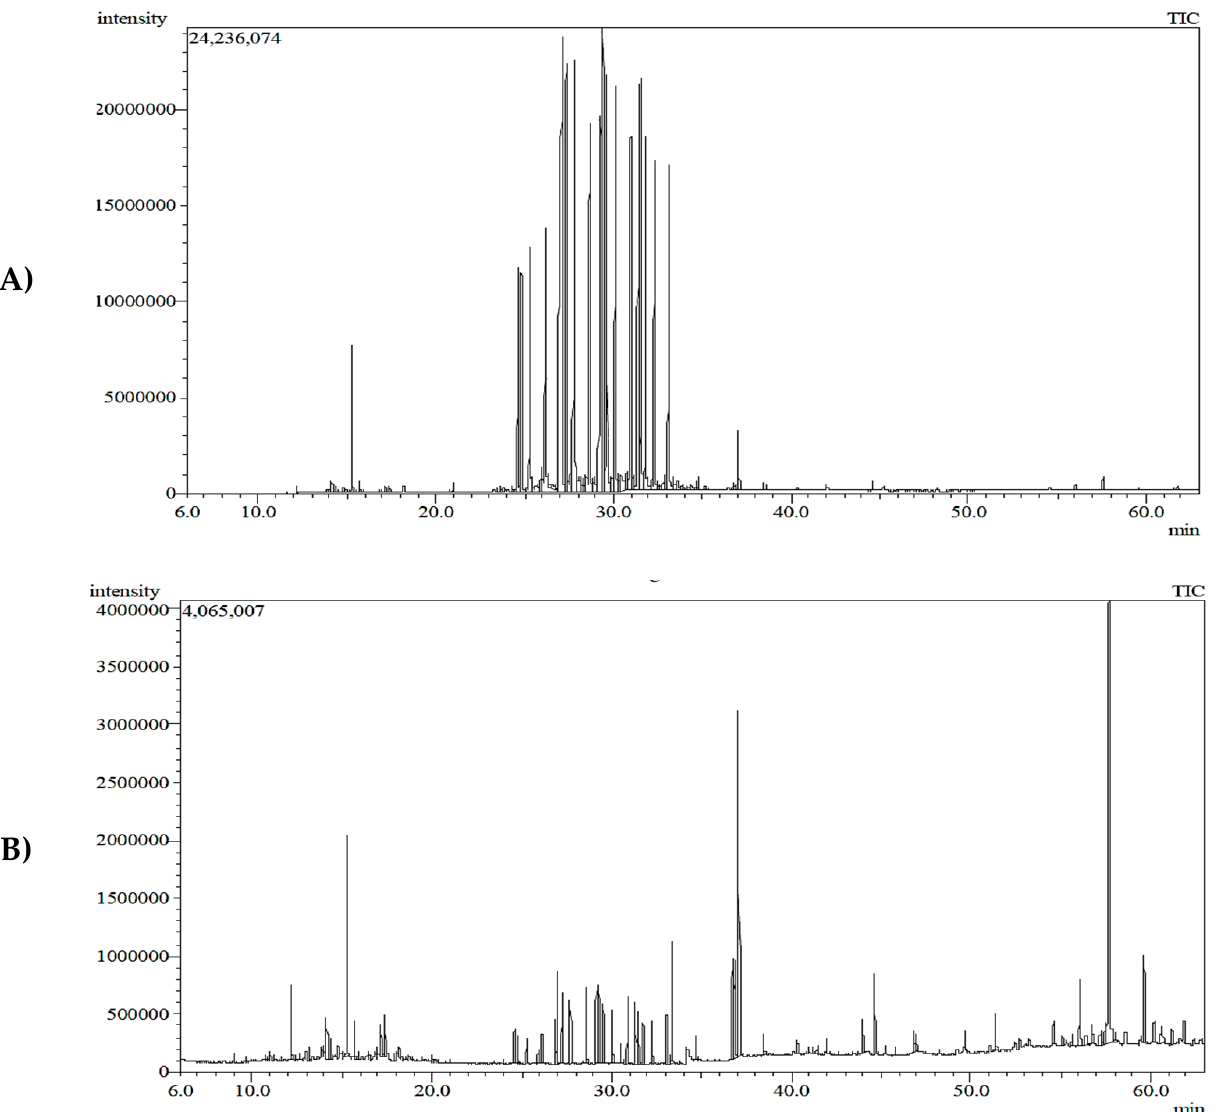
Figure 2. The spectra of n -hexane extract from Calystegia silvatica by gas chromatography–mass spectrometry: ( A ) leaves extract; ( B ) stems extract. The total phenolic contents of the leaves and stems of C. silvatica were 21.18 mg and 17.30 mg GAE/g of dry weight (DW), respectively, and the total flavonoids were 7.10 mg and 12.45 mg CE/g DW, respectively. The HPLC was used to identify and quantify the phenolic compounds that exist in the methanolic extract from the leaves and stems of C. silvatica. (Table 3). As a result, phenolic acids, polyphenols, tannins, flavanones, flavonoids, isoflavone and carboxylic acids were identified in both parts of the plant. The leaves and stems contained the phenolic acid gallic acid, at a concentration of 1.05 mg/100 g dry weight (DW) and 0.5 mg/100 g DW, respectively, and the phenolic acid ferulic acid, at a concentration of 0.28 mg/100 g DW and 0.60 mg/100 g DW, respectively. The polyphenols found in the leaves and stems were catechin, at a concentration of 0.19 mg/100 g DW and 0.24 mg/100 g DW, respectively, and caffeic acid, at a concentration of 0.1 mg/100 g DW and 0.003 mg/100 g DW, respectively. Additionally, the phenolic compounds found in the leaves and stems were pyrocatechol, at a concentration of 3.14 mg/100 g DW and 0.36 mg/100 g DW, respectively, and coumaric acid, at a concentration of 2.40 mg/100 g DW and 0.19 mg/100 g DW, respectively. The phenylacrylate polyphenol